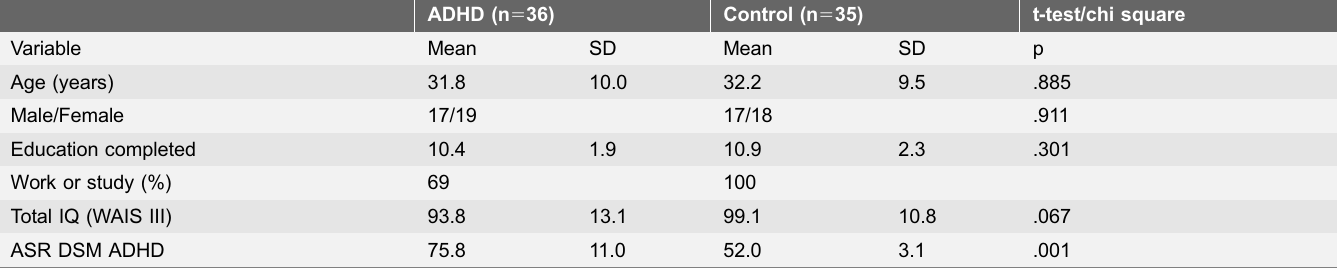
Table 1. Participant demographics and T-scores on the ASEBA Adult-Self-Report (ASR) DSM ADHD Problems